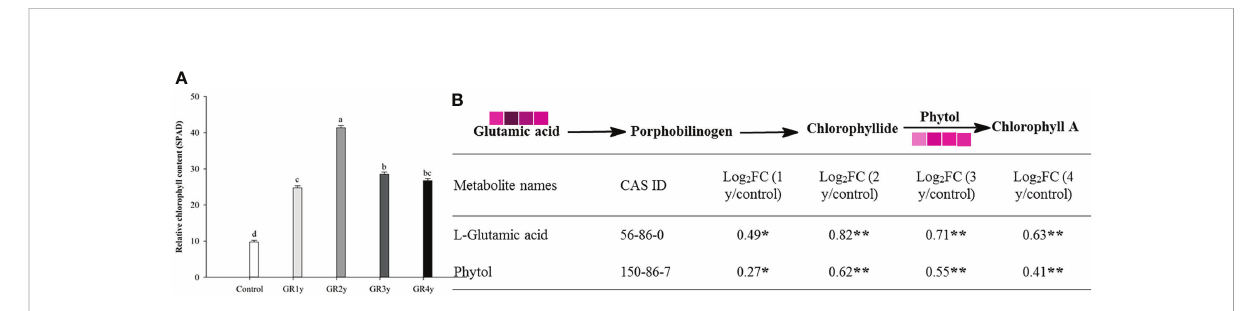
FIGURE 4 Effect of grazing rest during the spring regreening period on chlorophyll synthesis of degraded alpine meadows vegetation dominant grass Elymus nutans Griseb. (A) Effect of grazing rest during the spring regreening period on relative chlorophyll content of Elymus nutans Griseb. (B) Effect of grazing rest during the spring regreening period on metabolite contents in chlorophyll synthesis pathway of Elymus nutans Griseb. Bars represent SEs. Common letters above columns indicate no signi fi cant difference at P = .05. FC means fold change of relative content. * indicate signi fi cant difference at P = .05. ** indicate signi fi cant difference at P = .01. GR 1y, GR 2y, GR 3y and GR 4y mean grazing rest for 1 year, 2 years, 3 years and 4 years respectively represent log 2 FC ≤ 0.7, ≤ 0.6, ≤ 0.5, ≤ 0.4, ≤ 0.3, ≤ 0.2, ≤ 0.1, and ≤ 0.05, respectively.